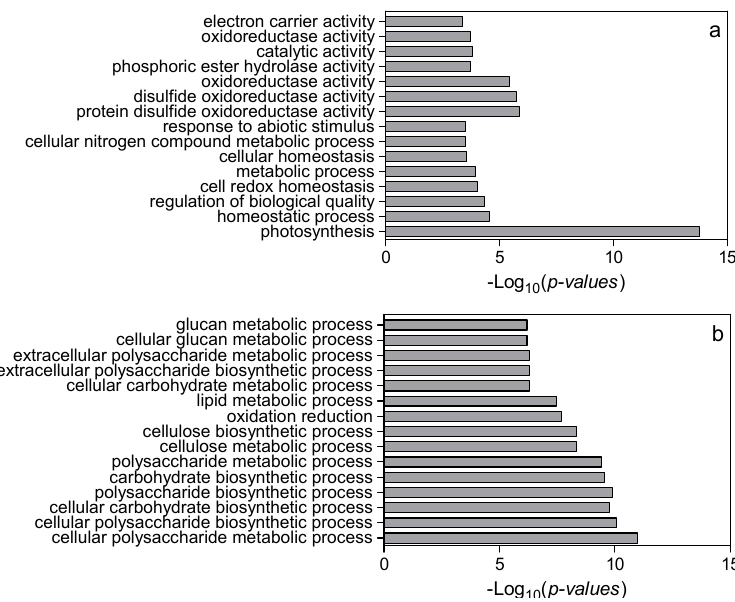
Figure 3. Significantly enriched gene ontology (GO) terms in downregulated ( a ) and upregulated ( b ) differentially expressed genes in low nitrogen versus high nitrogen in the sixth leaf. High nitrogen: 4 mM Ca(NO 3 ) 2 ; low nitrogen: 40 µM Ca(NO 3 ) 2 . After GO analysis, every significantly enriched GO term has a p -value. The smaller p -value, the more reliable GO result